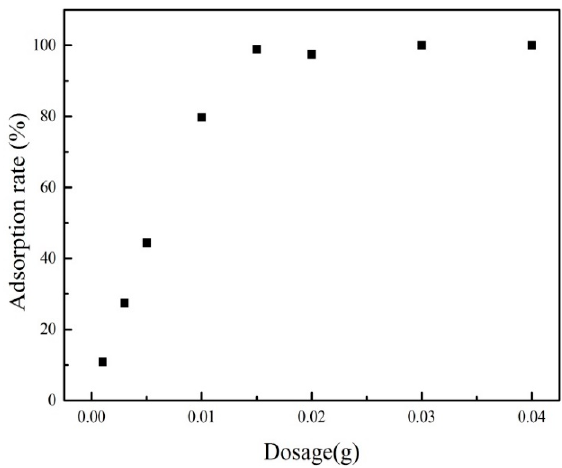
Figure 7. The effect of adsorbent mass on the adsorption of PRO onto ATP/Fe 3 O 4 /GO.